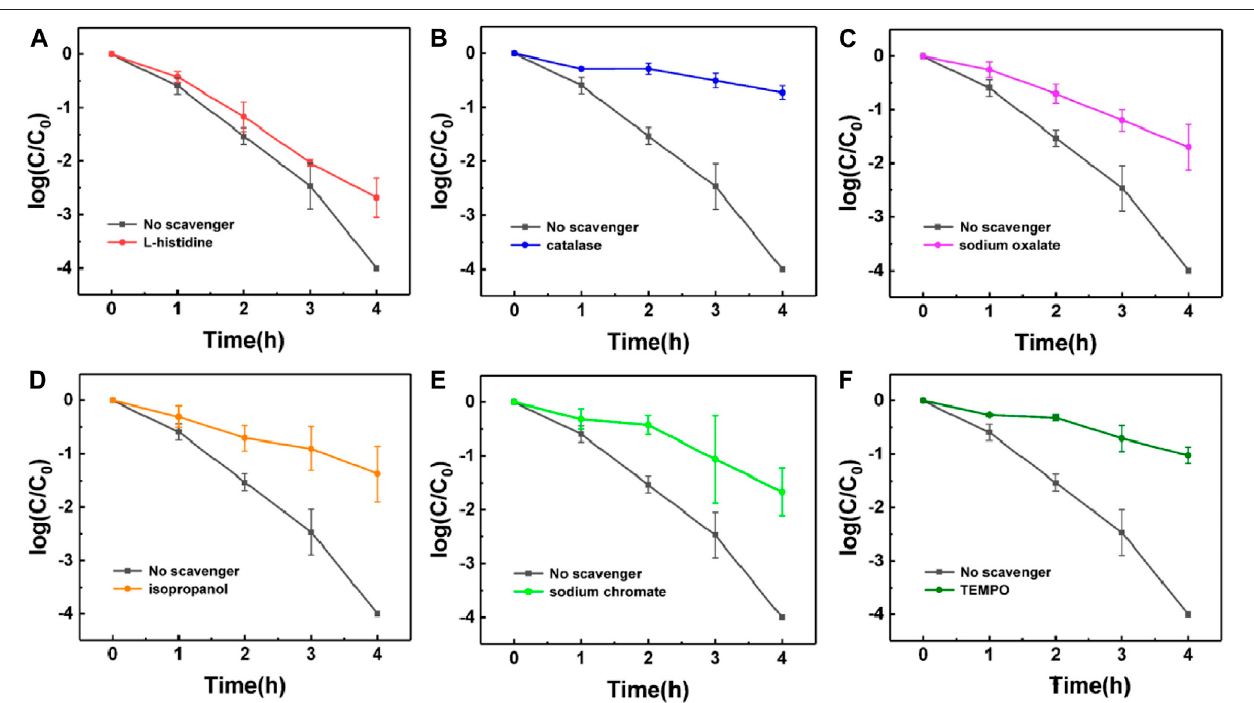
FIGURE 5 | Photochemical analysis of disinfection mechanism via addition of various scavengers using L -histidine (A) , catalase (B) , sodium oxalate (C) , isopropanol (D) , Cr (VI) (E) and TEMPOL (F) as scavenger respectively. In these disinfection performance curves, error bars represent the standard deviation of three replicate